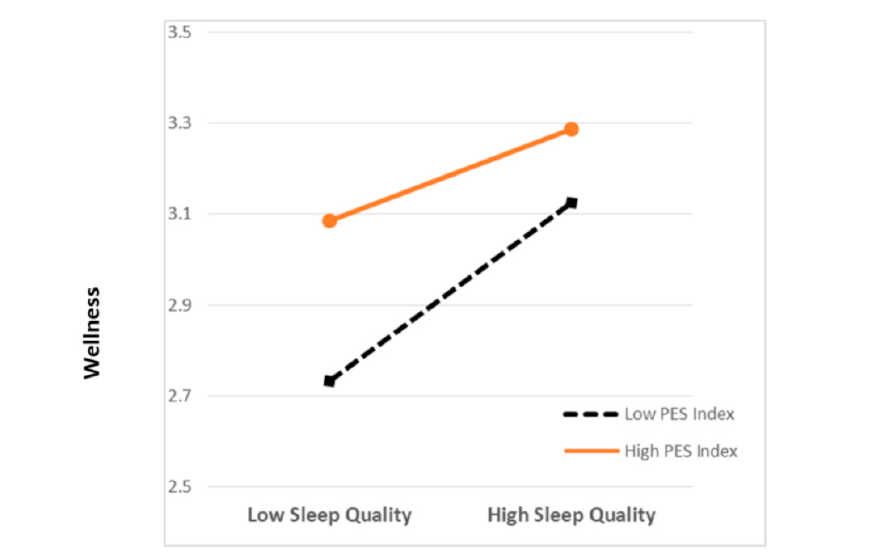
Model 1: Only included the general characteristics of the participants as predictors of wellness. Model 2: Sleep quality and nursing practice environment components were added. Model 3: The interaction term between sleep quality and nursing practice environment was added.